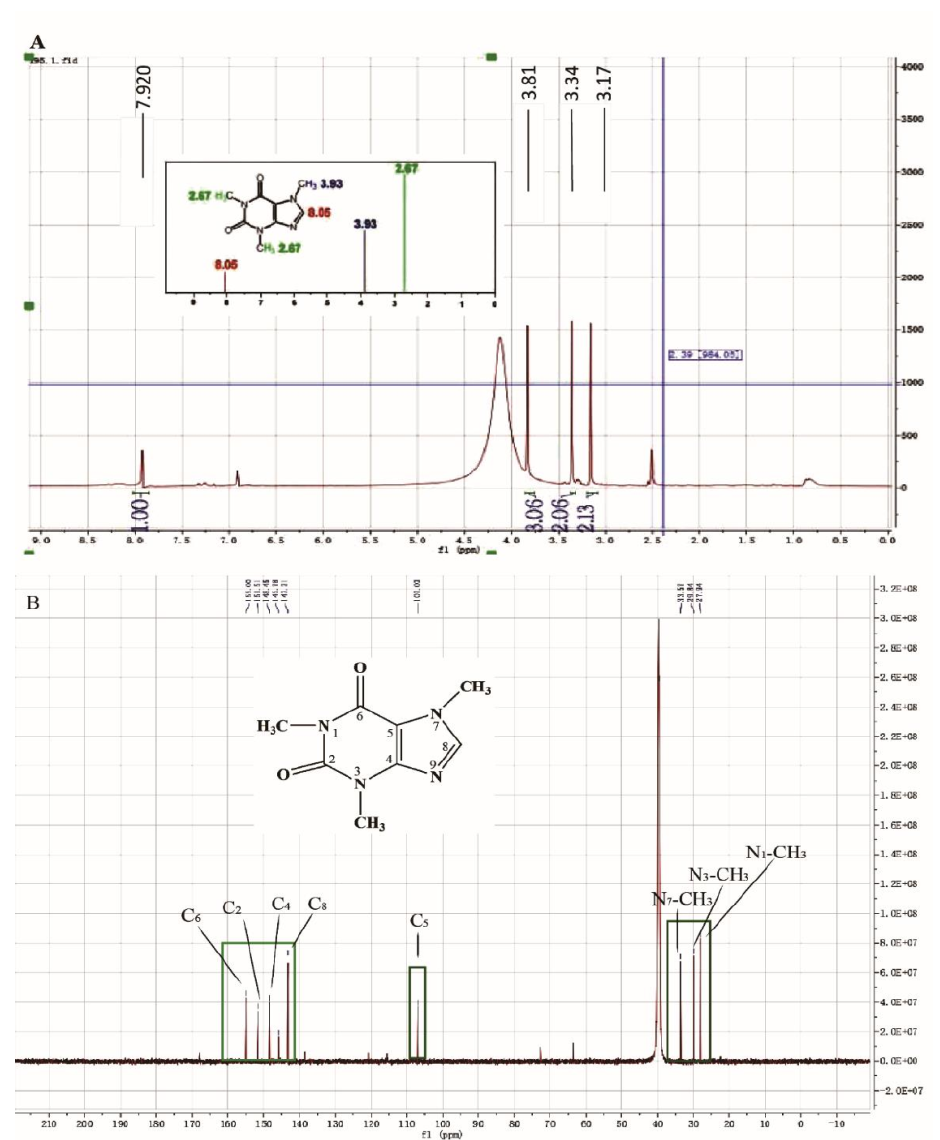
Figure 1. Nuclear magnetic resonance (NMR) analysis of Fu Brick tea element ( A ), carbon spectrum analysis; ( B ), hydrogen spectrum